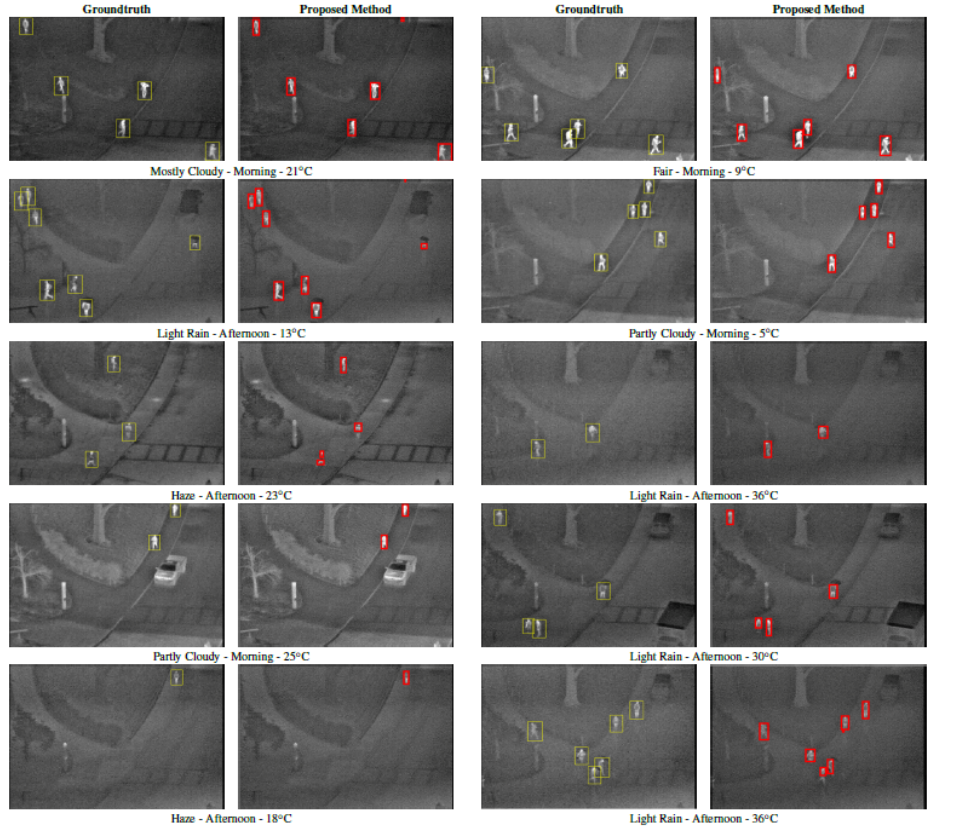
Figure 10. Detected pedestrians on images from the OSU thermal dataset after